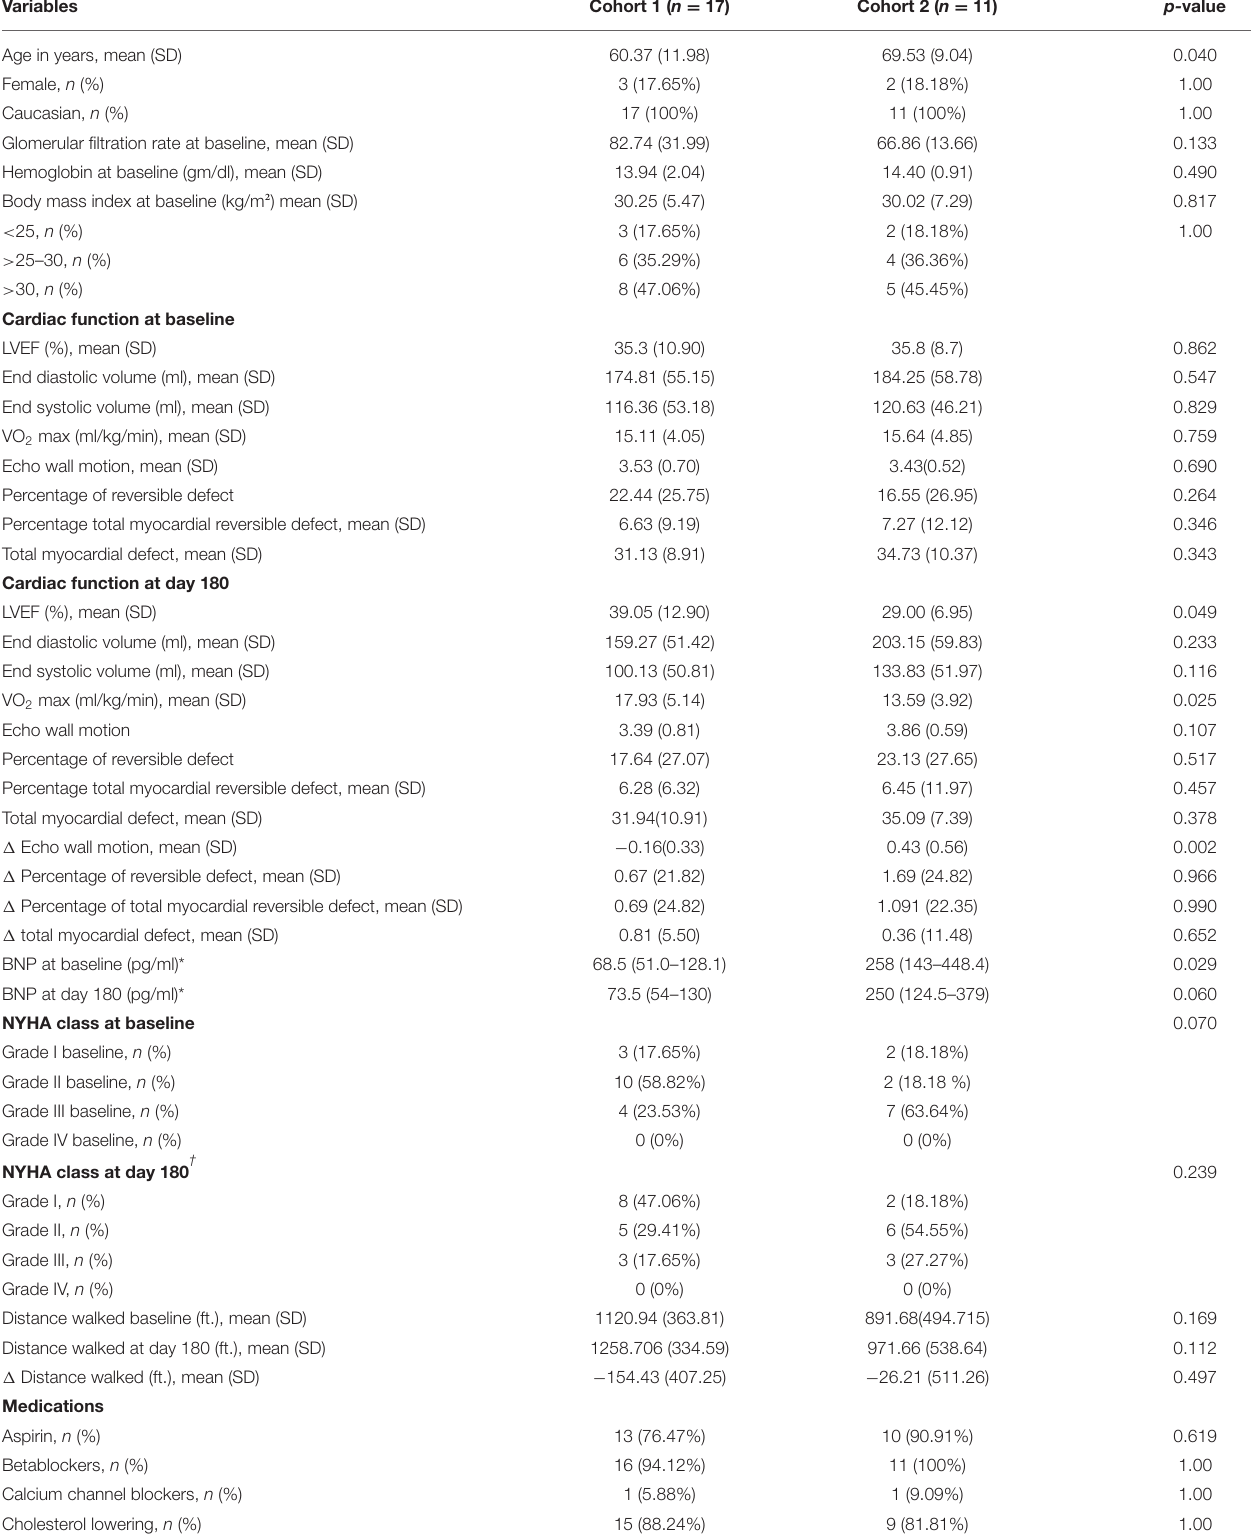
TABLE 2 | Clinical characteristics of the study